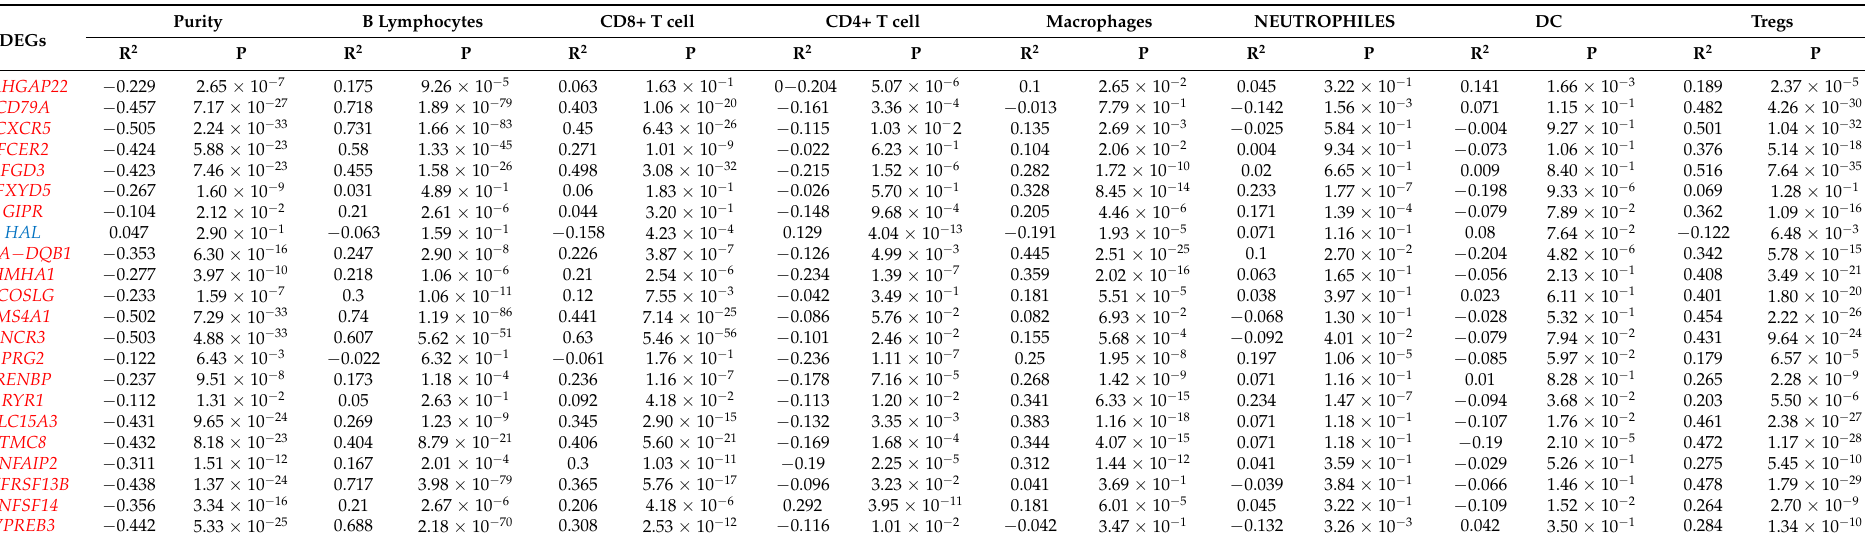
Table 2. Correlation analysis between candidate hub genes and immune cells from TIMER2.0 database. Red denotes DEGs with elevated expression in females and blue denotes DEGs with elevated expression in